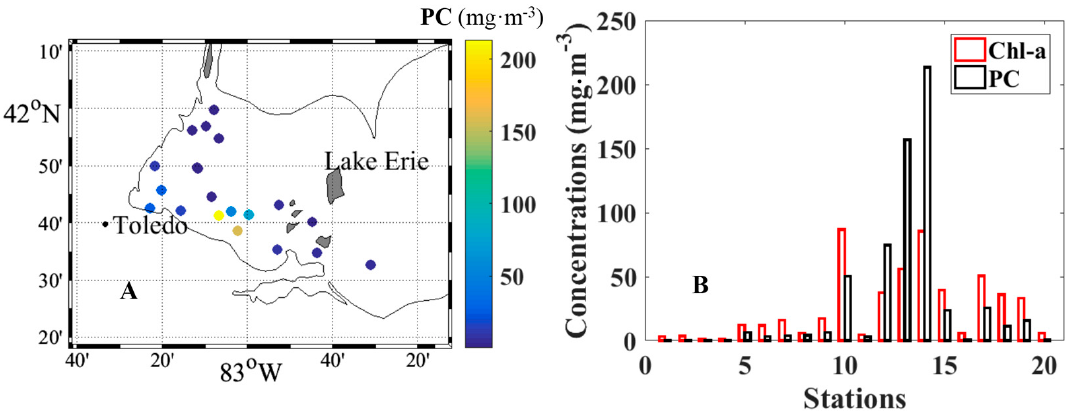
Figure 1. ( A ) Sampling locations in the western basin of Lake Erie with different colors reflecting the different phycocyanin (PC) concentrations. ( B ) The bar chart shows the chlorophyll a (Chl-a) and phycocyanin (PC) concentrations of each station.